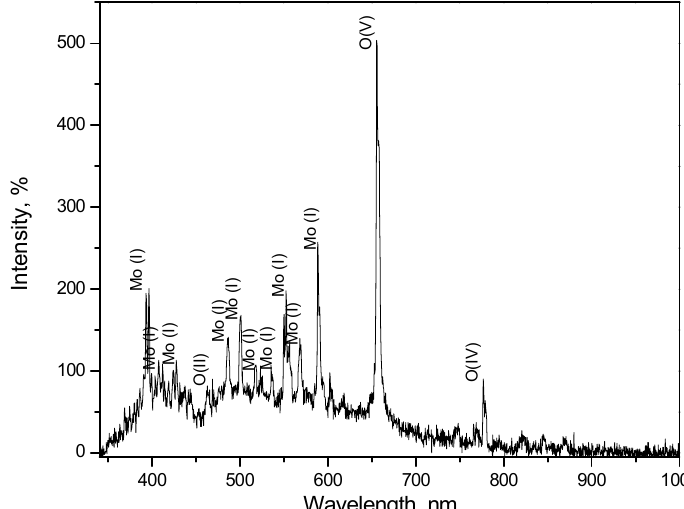
Figure 3. Spectrum recorded from plasma induced by a laser pulse (wavelengths from 250 to 1000 nm). The zone on the sample surface affected by laser pulse irradiation is almost circular with a diameter of ~2.2 mm (Figure 4), i.e., much larger than that of the laser spot (Φ = 200 μm).